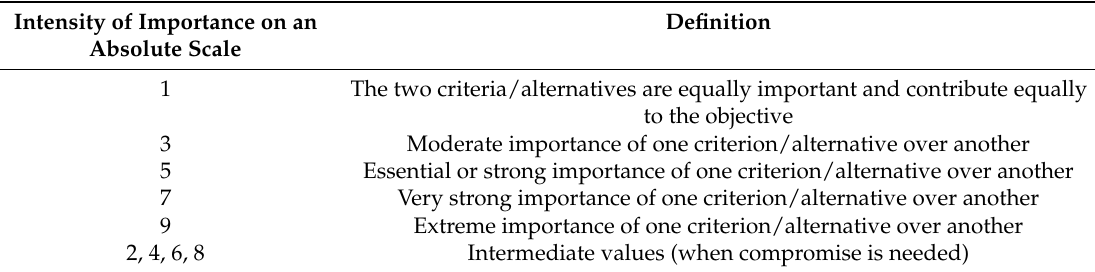
Table 1. The AHP pairwise comparison scale